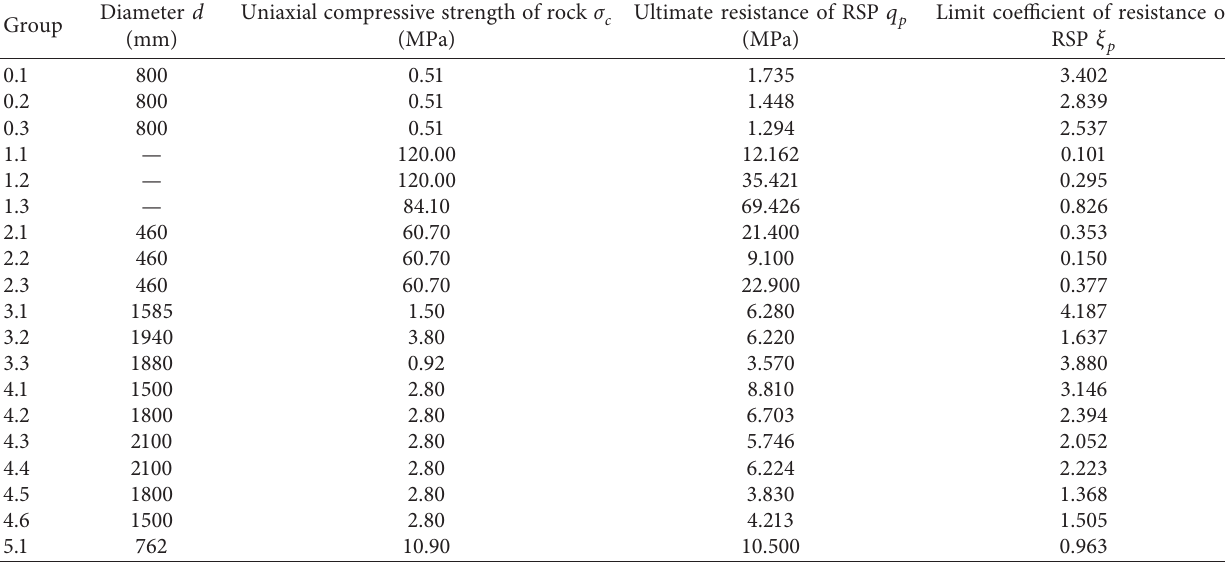
Table 9: Data from load tests of end-bearing capacities of piles socketed into rock.